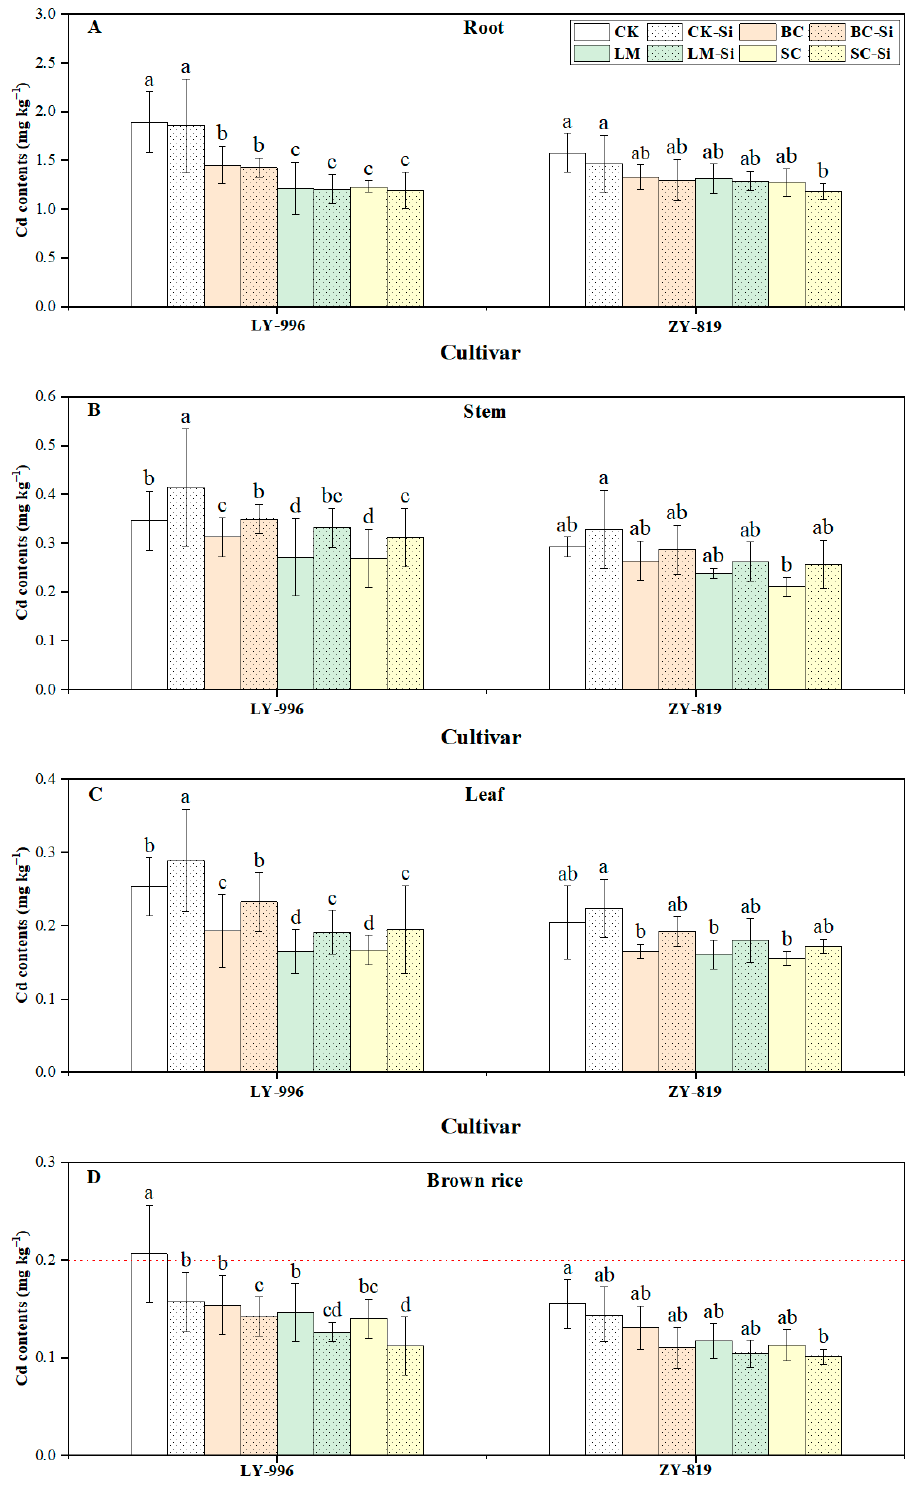
Figure 1. Effects of the soil amendments and foliar inhibitor on the Cd content of the early rice. ( A ) roots, ( B ) stems, ( C ) leaves, and ( D ) brown rice. The same letters indicate that no significant differences between the treatments for each cultivar were found using least significant difference tests ( p < 0.05). Different letters indicate that significant differences were found between the treatments for each cultivar using least significant difference tests ( p <